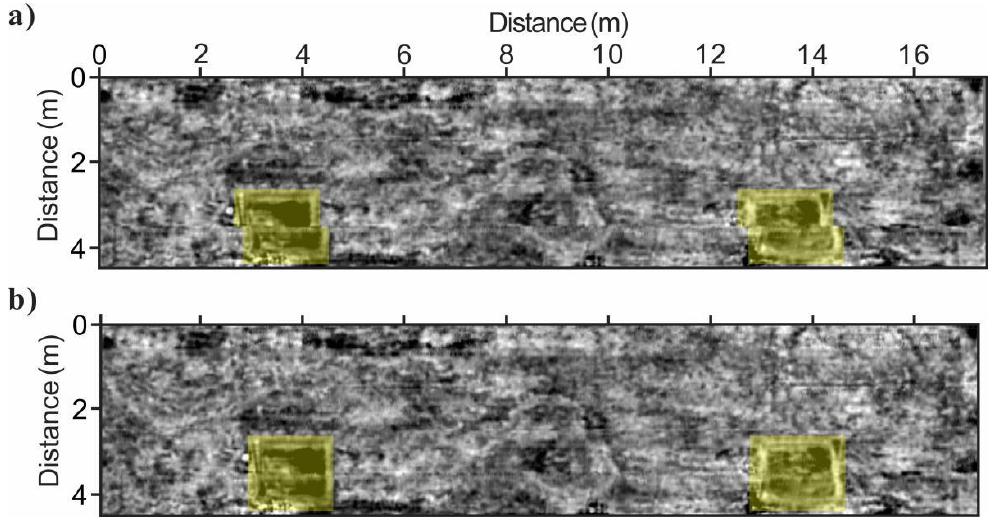
Figure 5. Horizontal slice of the full-coverage 3D GPR data: ( a ) direct combination; ( b ) using the proposed method in this paper. The yellow shaded areas indicate the locations of the backfill pits.